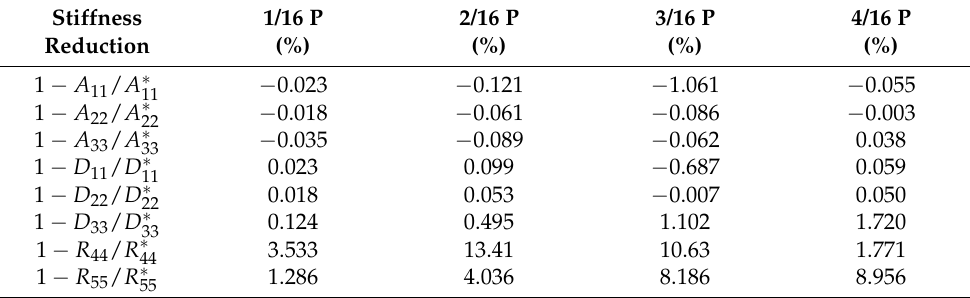
Table 10. Uncut samples SW. Stiffness reduction in terms of flute offset.